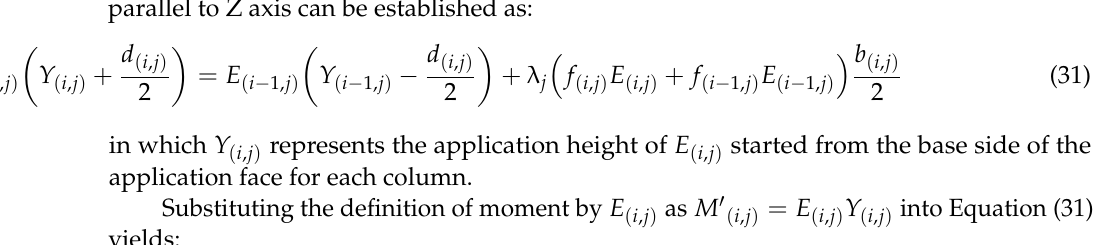
Figure 3. Planar schematic of forces acting on a single column. The moment equilibrium equation about the axis going through the base center